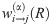
A schematic illustration of the random walk strategy as defined in Eq (16).In (a) we depict locations on the plane (represented by circles); the probability to go from location i to a different site is determined by two types of transition probabilities: wi→j(α)(R), which is a constant, to a site j inside a circular region of radius R centered in the location i and wi→k(α)(R), for a displacement to the site k outside the circle of radius R, that considers long-range transitions with a power-law decay proportional to dik-α, where dik is the distance between sites i and k. In (b) we present Monte Carlo simulations of a discrete-time random walker that visits the stations in BSS in the cities of Chicago and New York following the random strategy defined by the transition probabilities in Eq (16). The information of the values N, R and α used in each system is reported in Table 1. The total number of transitions between stations in each simulation is t = 100 and we assign a colored line to each of the displacements. The scale in the color bar represents the discrete time t at which each transition occur. The maps were drawn from base maps of satellite imagery (Source: http://server.arcgisonline.com/ArcGIS/rest/services/World_Shaded_Relief/MapServer) and the Matplotlib Basemap package (https://pypi.python.org/pypi/basemap/1.0.7).